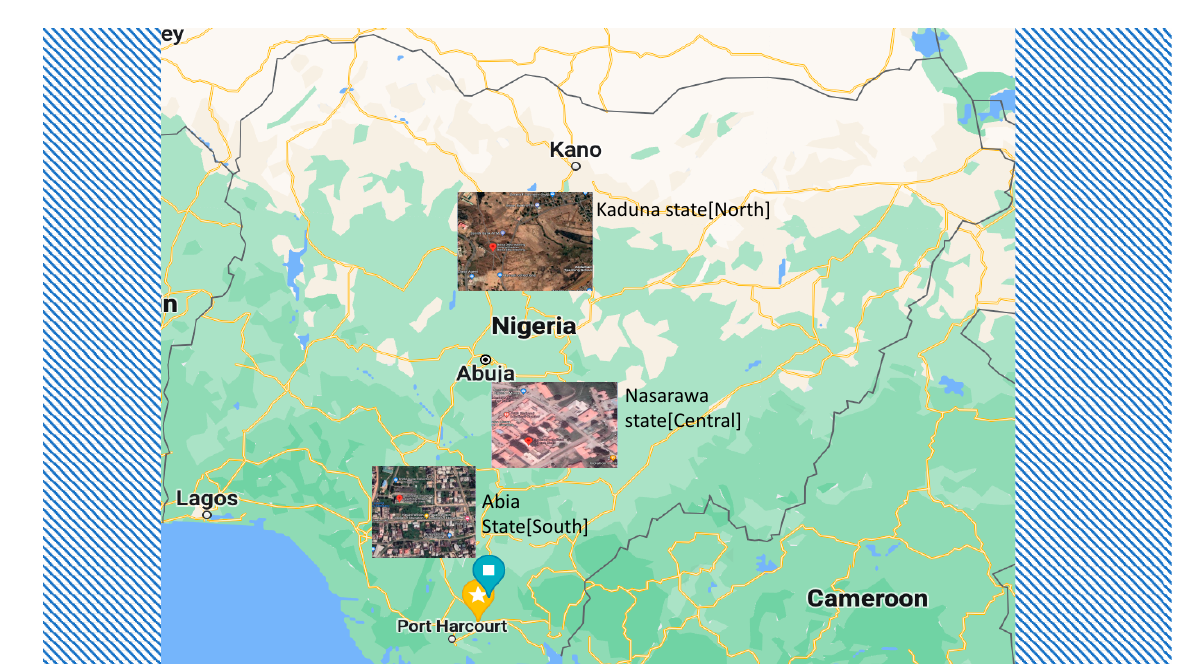
Figure 1. Chikungunya and malaria study sites in Nigeria.